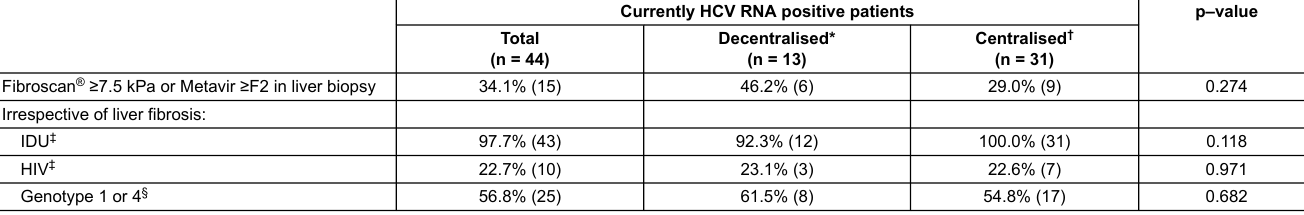
Table 6: Currently HCV–RNA positive patients qualifying for reimbursement of interferon–free DAA (Direct–acting antivirals) treatment in